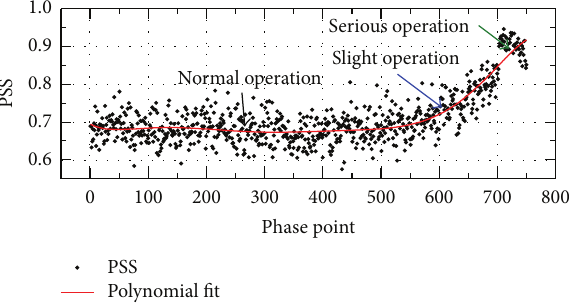
Figure 12: (a) Curve of 𝐸 1 (𝑑) and 𝐸 2 (𝑑) and (b) curve of 𝐶 𝑖 (𝜏) .